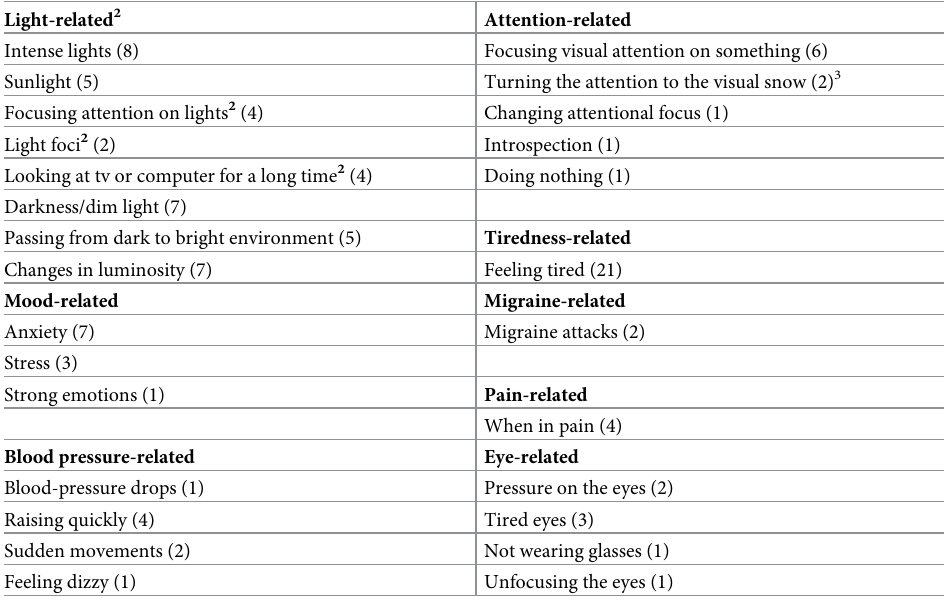
Table 5. Triggers of visual snow (Study 1; N = 78): Number of participants reporting particular types of triggers are indicated in parentheses (some participants reported more than one type) 1